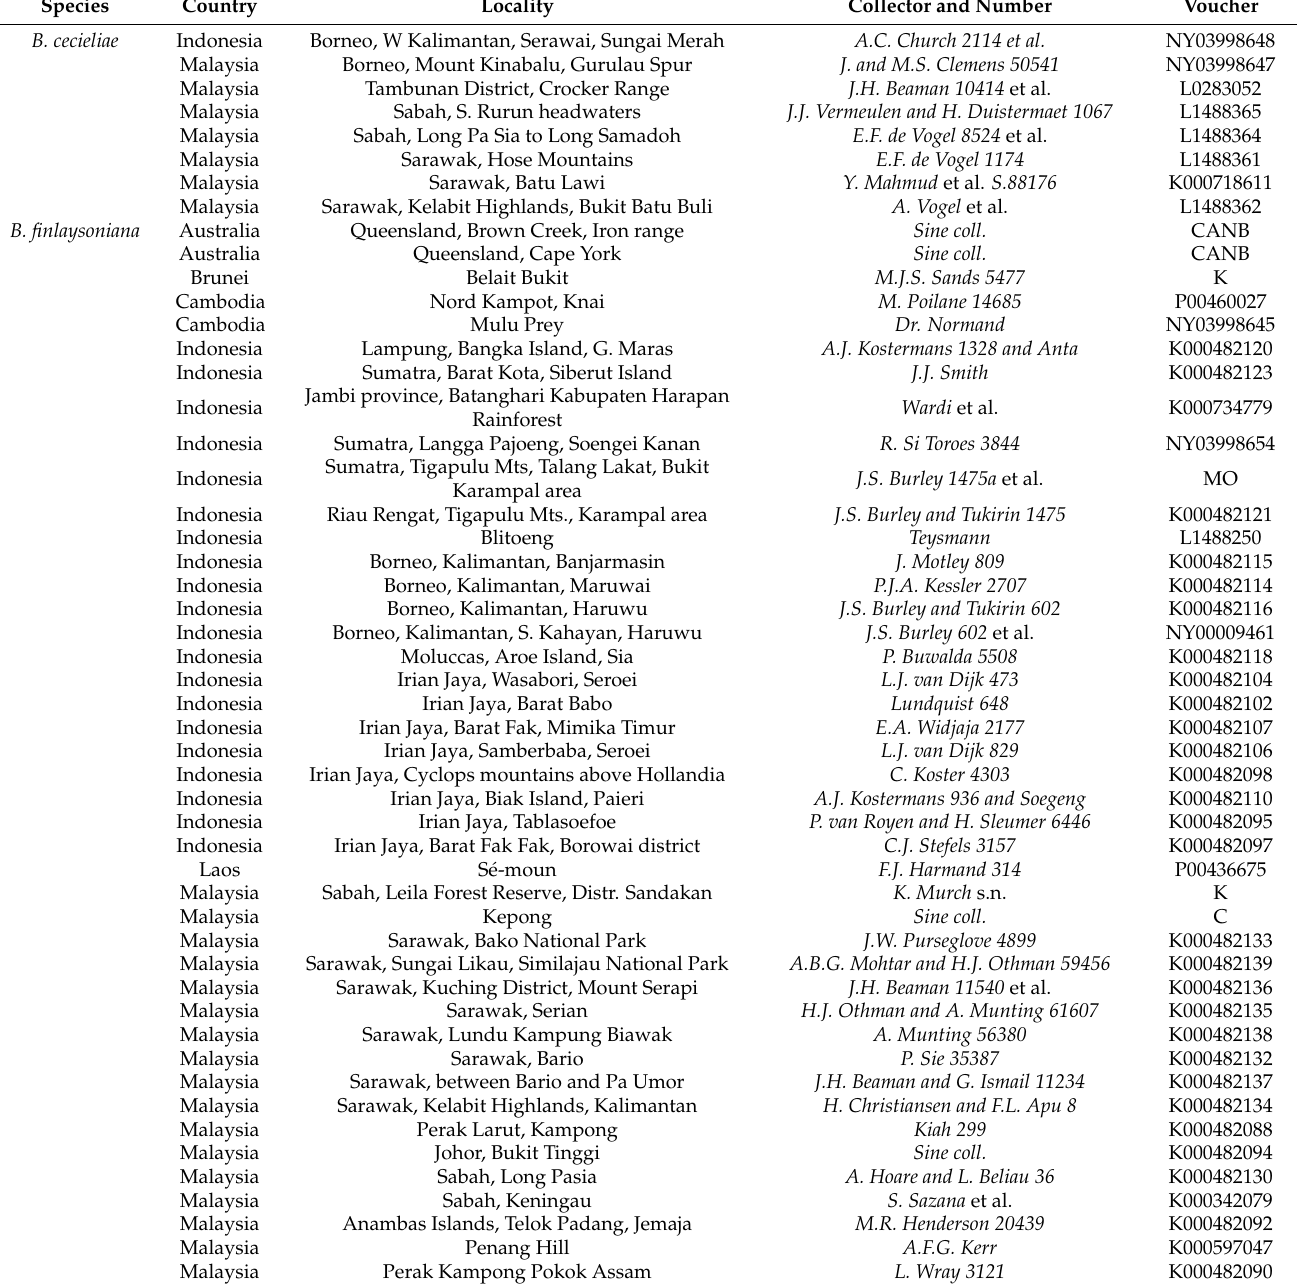
Table A1. List of collections and bibliographic resources of the three studied species with countries, localities, collector (including collector number) and voucher. Acronyms of herbaria: BM (The Natural History Museum, London, UK); C (University of Copenhagen, Denmark); CANB (Australian National Herbarium, Canberra, Australia); G (Conservatoire et Jardin Botaniques de la Ville de Gen è ve, Switzerland); HUH (Harvard University, Cambridge, USA); K (Royal Botanic Gardens, Kew, UK); L (Naturalis Biodiversity Center, Leiden, The Netherlands); MO (Missouri Botanical Garden, Saint-Louis, USA); NY (New York Botanical Garden, USA); P (Mus é um National d’Histoire Naturelle, Paris, France); PH (Academy of Natural Sciences, Philadelphia,